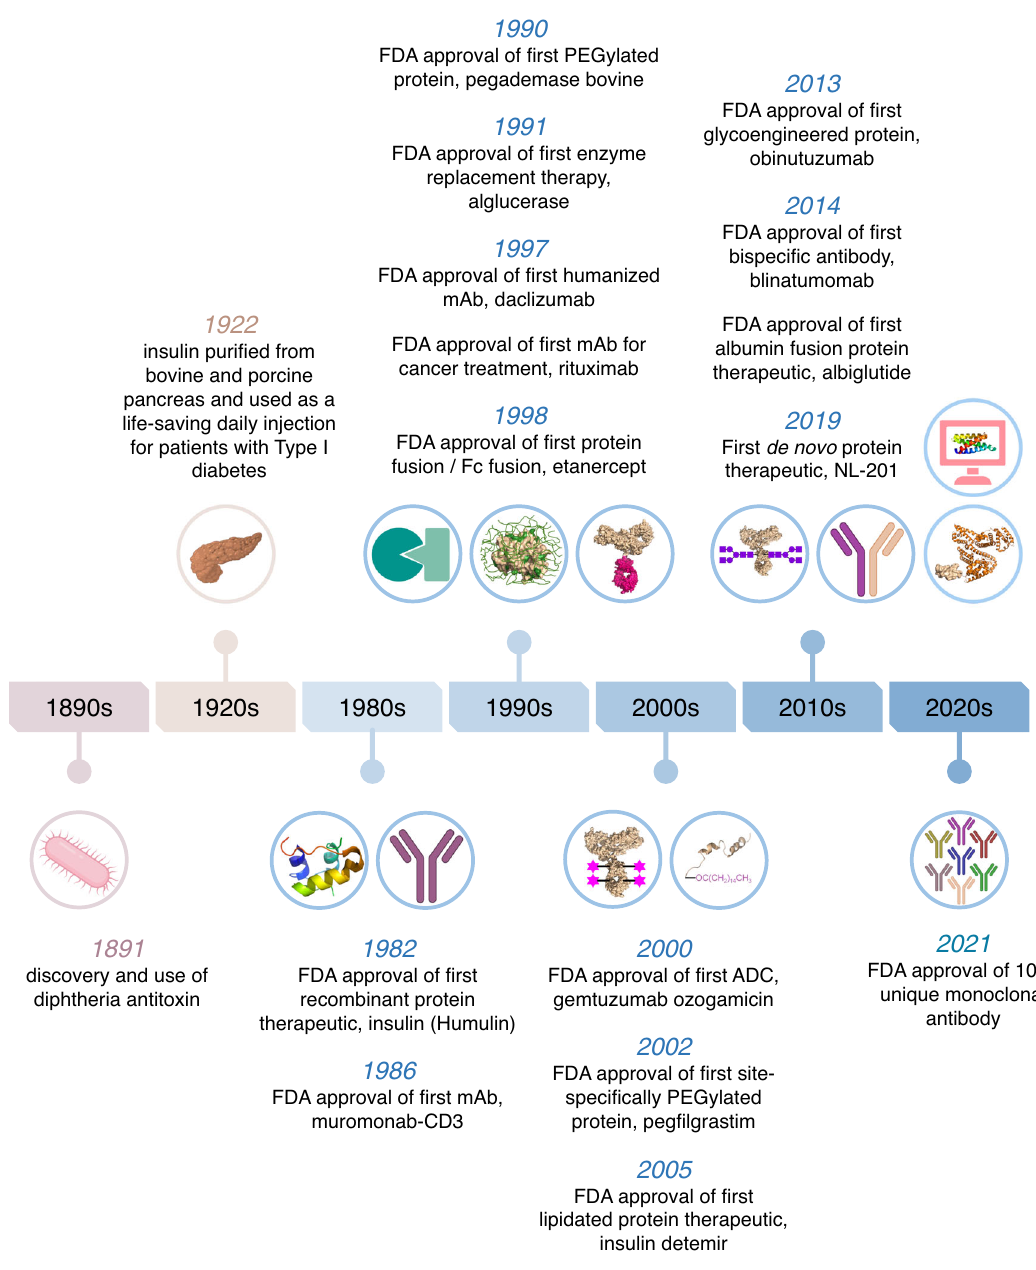
Fig. 1 | A timeline of signi fi cant advances in the development of protein-based